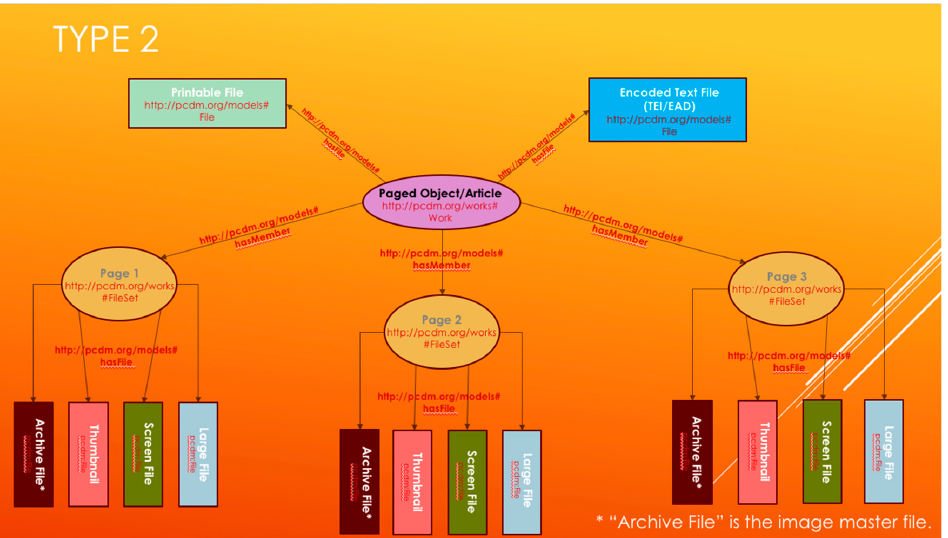
Figure 8. One of the more common types of structure defined in IU’s METS is shown mapped as relationships that can be defined in Fedora 4. Diagram created by Madison Chartier, a graduate student in the School of Informatics, Computing, and Engineering at Indiana